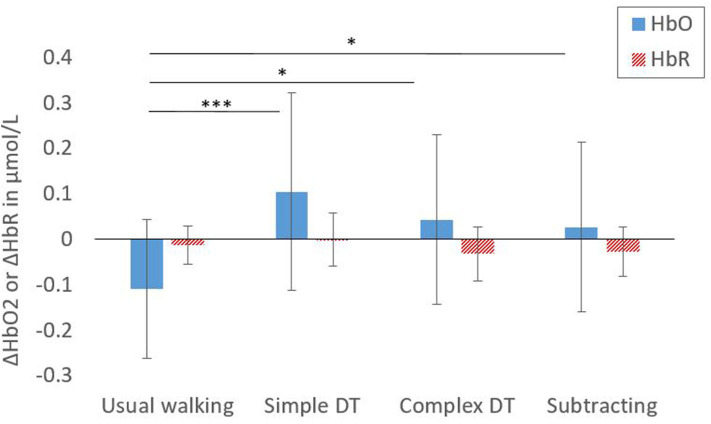
Mean values for ΔHbO2 and ΔHbR in the dorsolateral prefrontal cortex. Significance level between conditions: *p < 0.05; ***p < 0.001. Error bars represent ±1 SD.